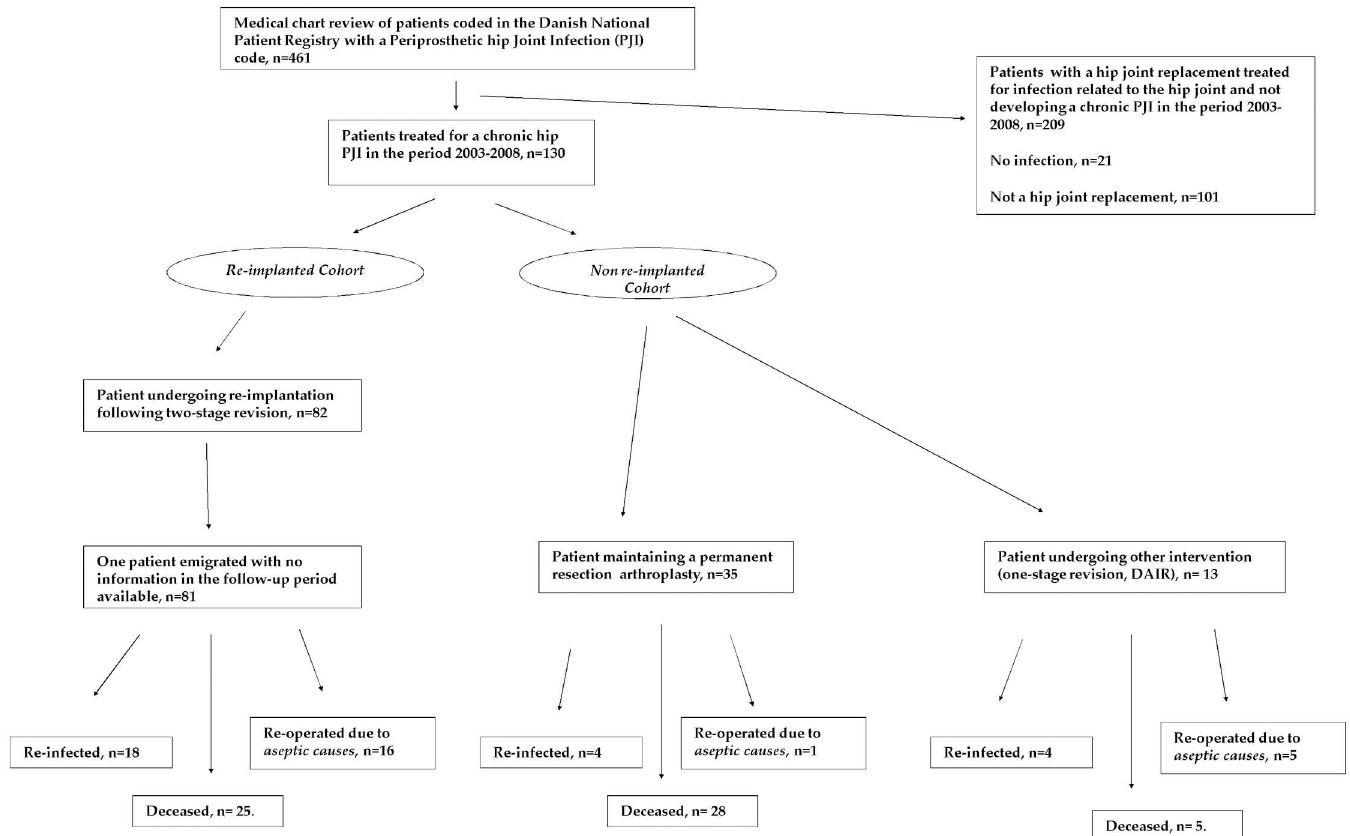
Fig 1. Patient flowchart. Flowchart of the 130 patients includedin the study.